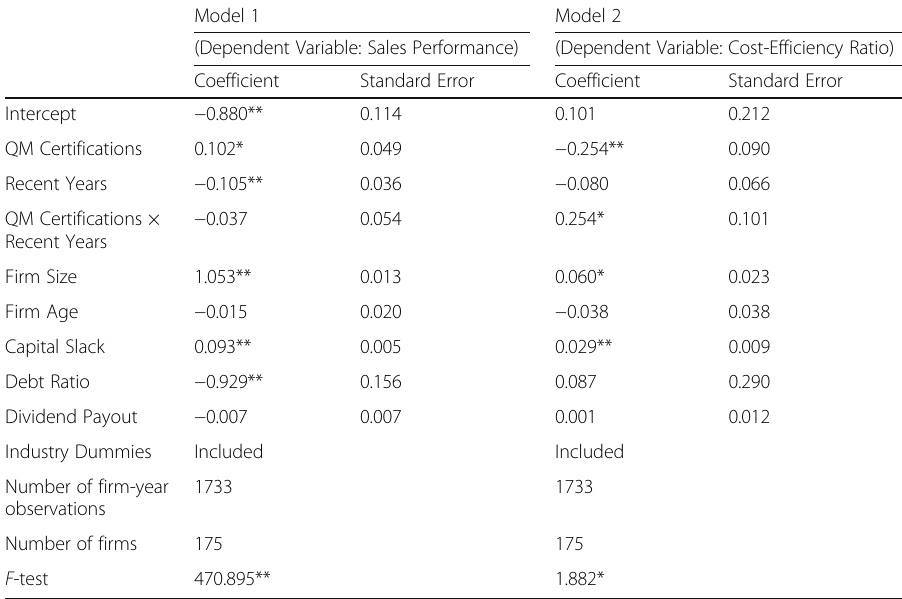
Table 2 Multivariate regression